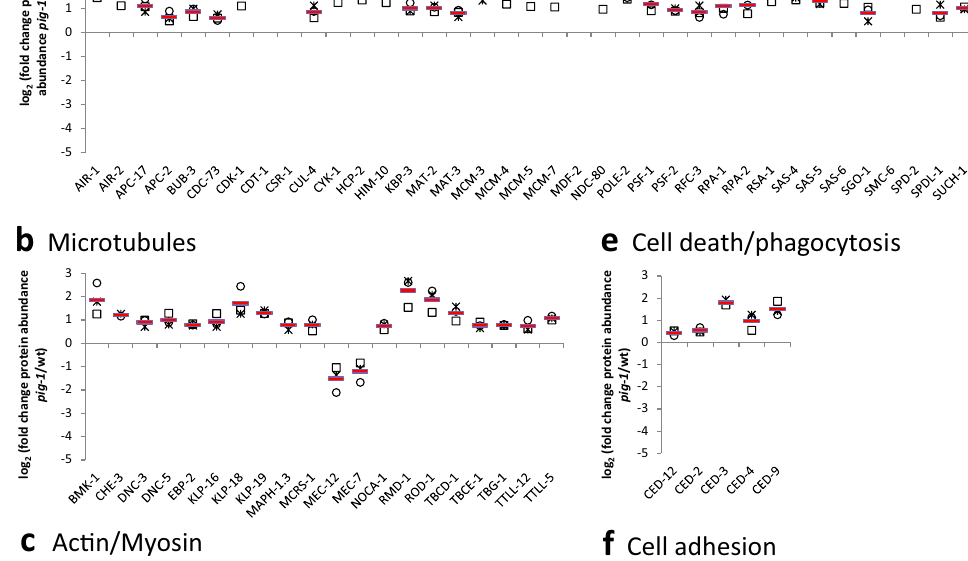
CED-2 and CED-12, all show increased abundance in pig - 1 mutant embryos (Fig. 5e). We also detected altered abundances of several cell adhesion proteins in pig - 1 mutant embryos (Fig. 5f). These data support the reported function of PIG-1 in cell detachment (‘shedding’) by interfering with the cell-surface expression of cell adhesion proteins in C . elegans caspase-deficient embryos 14 . PIG-1-mediated cell shedding was suggested to involve endo- cytosis 14 . Consistent with this proposal, we found that the vesicle trafficking protein ARF-1.2 (ADP-Ribosylation Factor-related), which is required for cell shedding 14 , was downregulated in pig - 1 mutants, while the abundance of other vesicle trafficking proteins was upregulated (Fig. 5g).